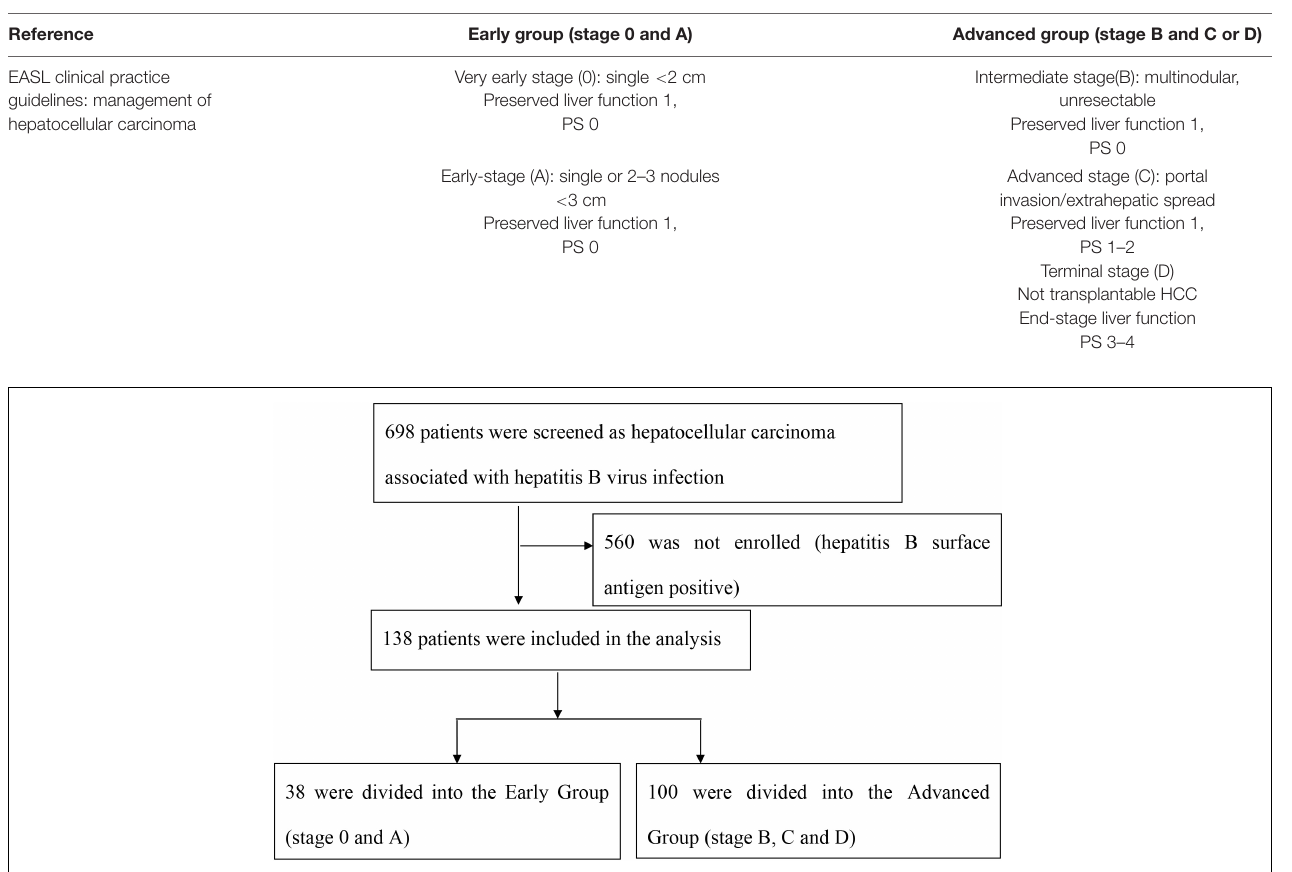
TABLE 1 | HCC stage grouping criteria.